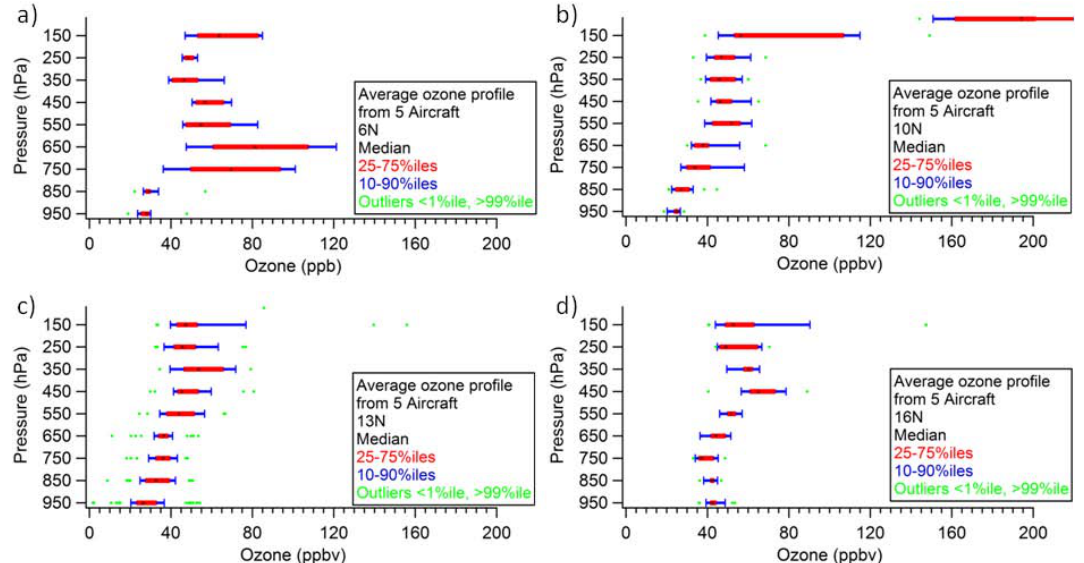
Fig. 10. Average vertical profiles of ozone concentrations in bins of 100hPa of atmospheric pressure at (a) 6 ◦ N, (b) 10 ◦ N, (c) 13 ◦ N, and (d) 16 ◦ N based on 1-min data from the BAe-146, the DLR Falcon, the French Falcon and the M55 between 20 July and 21 August. The black marker is the median, the red box the range of the 25 to 75 percentiles, the blue whiskers the range of the 10 to 90 percentiles and the green points outliers less than the 1 percentile and greater than the 99 percentile. Ozone concentrations in the top layer are limited to data between 100 and 50hPa bin and exceed